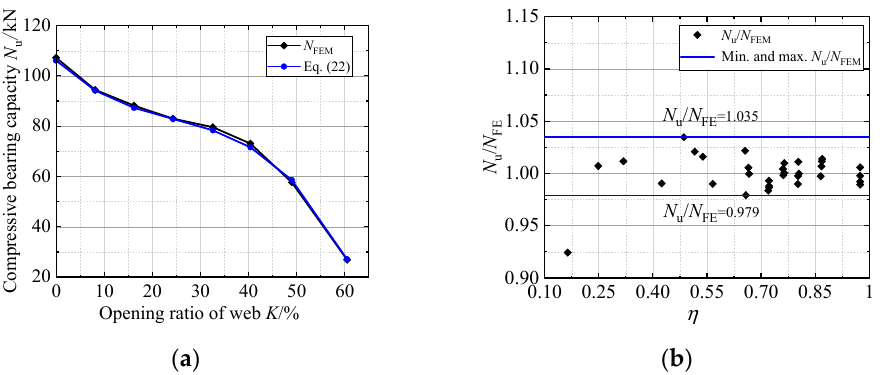
Figure 25. Relationship between reduction factor and opening ratio.